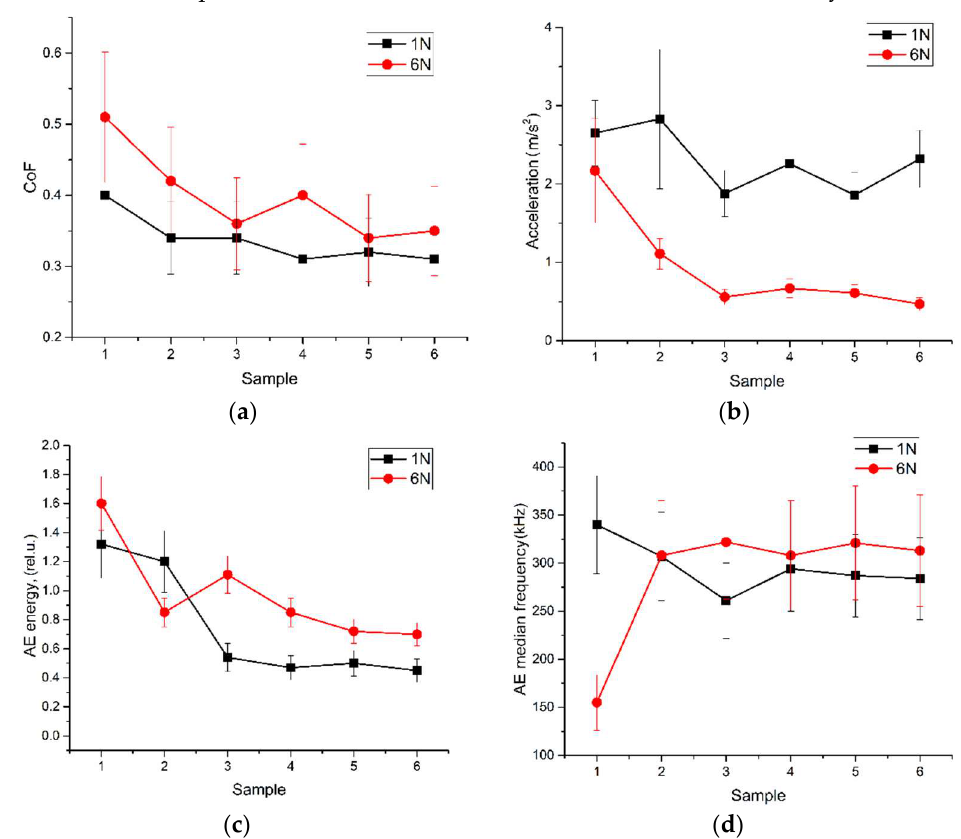
Figure 17. Averaged CoF values ( a ), vibration acceleration ( b ), AE energy ( c ) and AE median fre- quency ( d ) obtained from samples in sliding at 1N and 6N normal load: 1—ZrN, 2—CrN, 3—ZrCrN(0.5), 4—ZrCrN(3.5), 5—ZrCrN(5) and 6—ZrCrN(8).